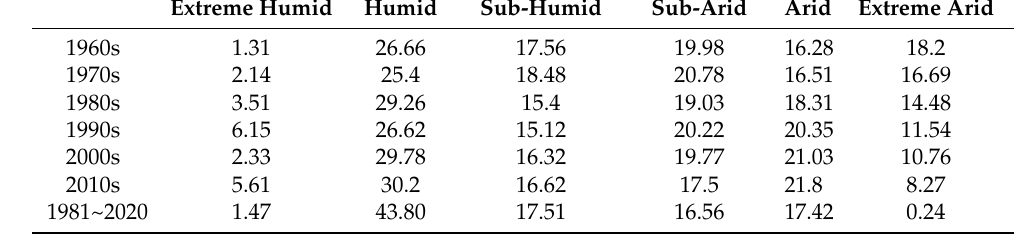
Table 3. The proportions of the area of different climate zones to the area of China in different periods from 1961 to 2020 (unit: %). Extreme Humid Humid Sub-Humid Sub-Arid Arid Extreme Arid